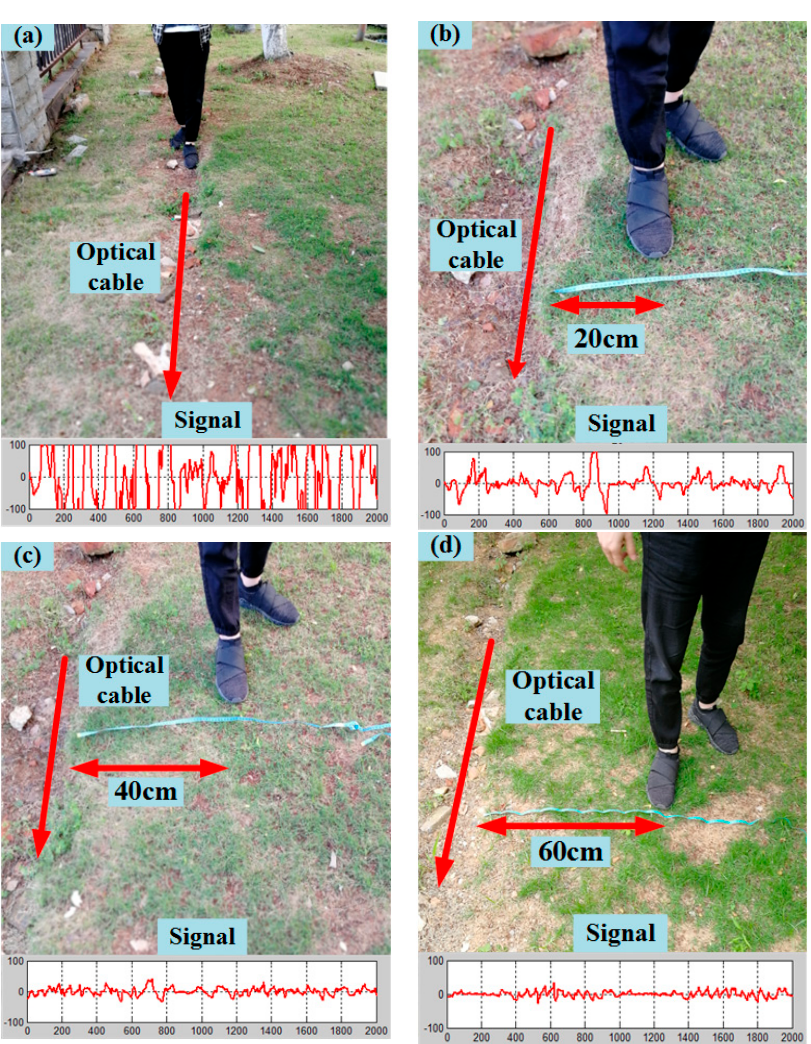
Figure 6. Four types of underground fence intrusion. ( a ) Walking on the buried cable; ( b ) walking parallel to the cable at a distance of 20 cm; ( c ) walking parallel to the cable at a distance of 40 cm; and, ( d ) walking parallel to the cable at a distance of 60 cm.